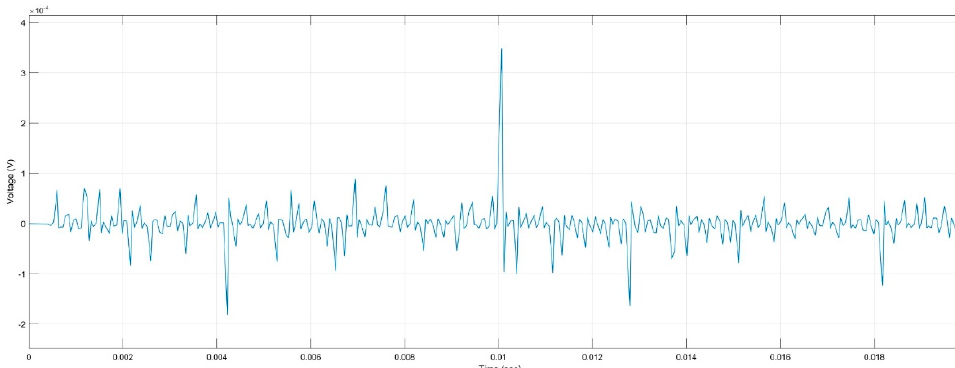
Figure 5. PD Activity for ER, 5 kV, 2 h, r.